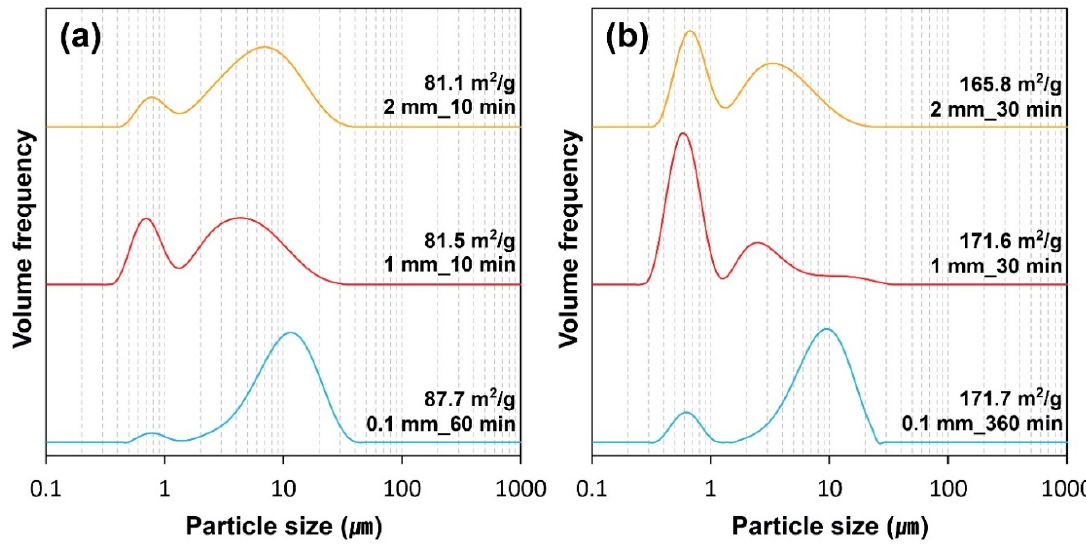
Figure 9. Comparison of particle size analysis results for ground talc powder having similar specific surface area. The BET specific surface areas are ( a ) 81–88 m 2 / g and ( b ) 165–172 m 2 / g. The increased aggregation of ground talc with 0.1 mm balls than with 1 mm or 2 mm